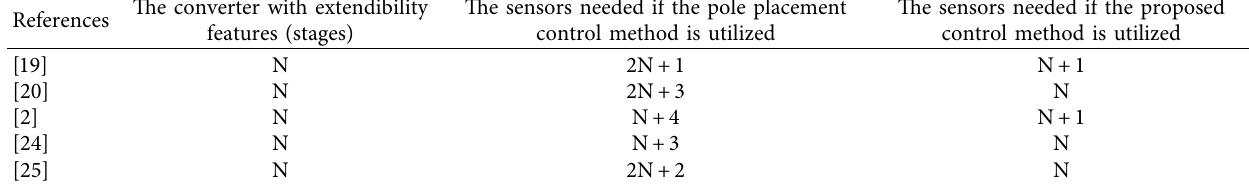
Table 3: Advantages of the proposed control in extendable multiinput DC-DC converters.